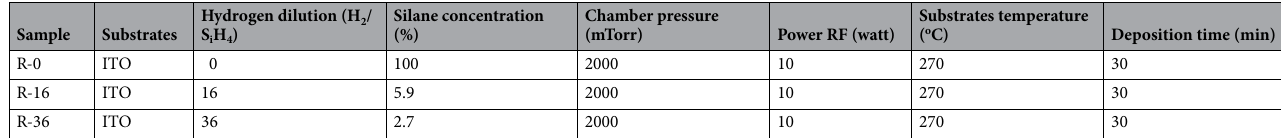
Table 1. Deposition parameters for the (R-0 to R-36) layers used in solar